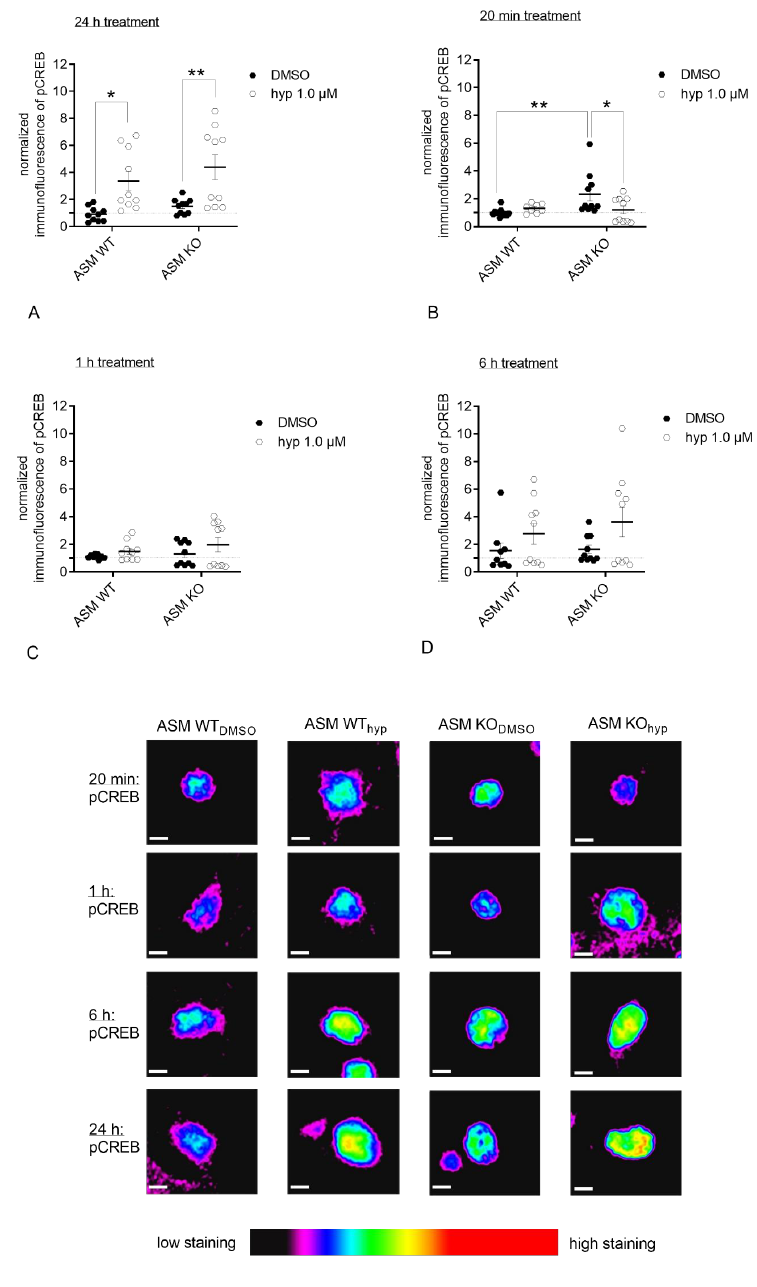
Figure 7. Genetic ASM deficiency impacts hyperforin-induced CREB-phosphorylation in excitatory primary murine neuronal cells. ( A ). 24 h after hyperforin (1 µM) stimulation, both ASM WT and ASM KO excitatory neurons showed a significant increase in pCREB staining compared with control conditions. ( B ). After a 20 min treatment of ASM KO and ASM WT neurons with hyperforin, distinctive hyperforin-induced changes were visible. While in ASM WT neurons after hyperforin application, a small positive trend was visible towards stronger pCREB staining, ASM KO neurons contrarily showed significantly decreased pCREB levels. ( C ). 1 h after hyperforin application, no treatment or genotype-induced e ff ects were observed. ( D ). 6 h after hyperforin stimulation, no treatment or genotype-induced e ff ects were observed. ( E ) Representative images of pCREB staining in single nuclei of excitatory murine neurons after indicated treatments and time points. Scale bar indicates 5 µ m. Bars indicate mean ± SEM; n = 2 cell batches, 1 cover slip analyzed per batch, 3–7 regions analyzed per cover slip; * p ≤ 0.05, ** p ≤